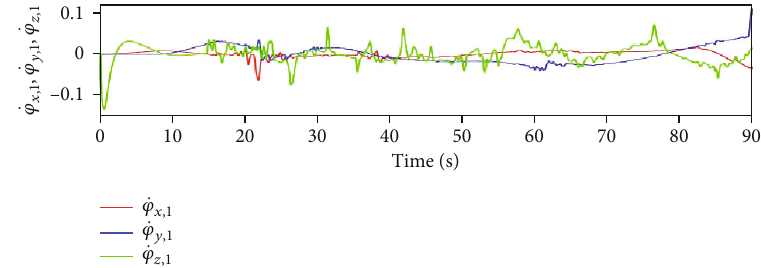
Figure 12: The derivative of virtual law _ φ